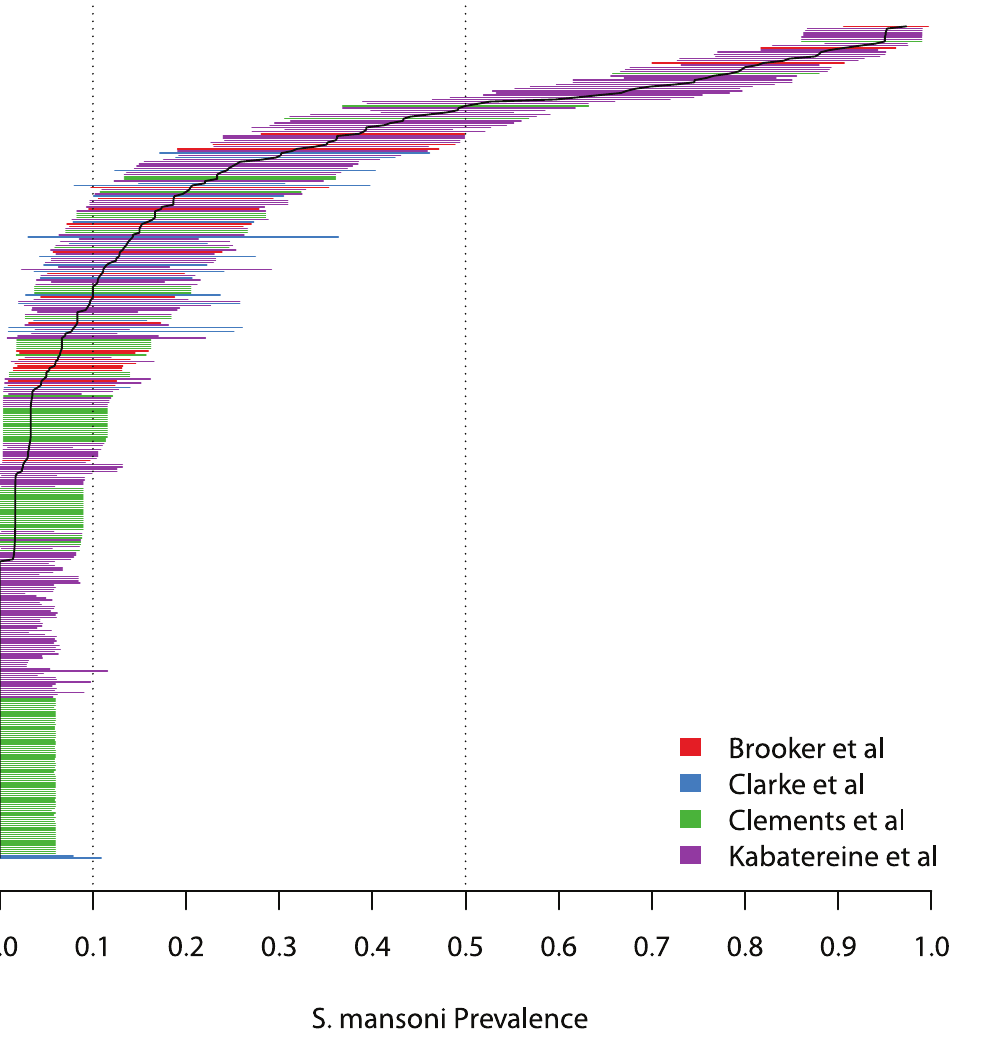
(Figure 3B) and curtailed (Figure 3C) sampling as a function of the full sample prevalence and overlay the expected ASN curves.